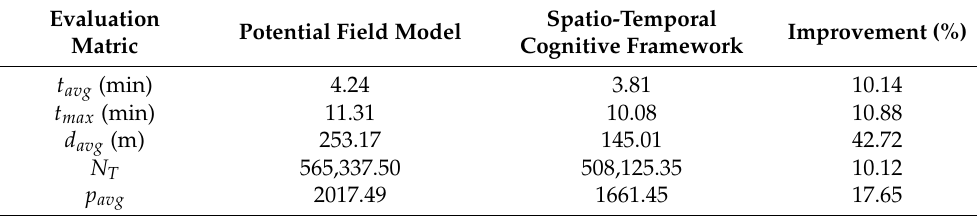
Table 2. The performance of route choice strategies of two route choice